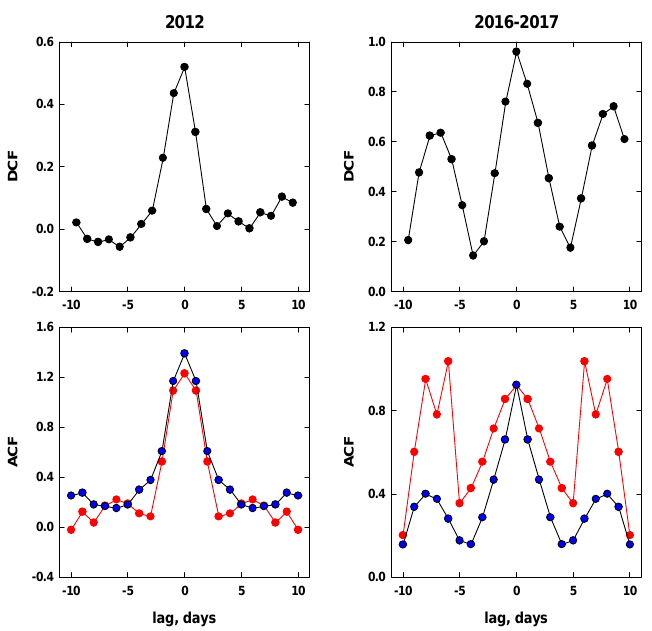
Figure 2. Upper left: Discrete Correlation Function (DCF) of optical R-band flux and γ -ray flux for CTA 102 during the outburst of 2012, adapted from [1]. Upper right: The same for the outburst of 2016–2017. Bottom panel: auto-correlation functions for corresponding time intervals: red—for optical R flux, blue—for γ -ray flux. During both outbursts, there are no delays between γ -rays and optical, implying that the sites of synchrotron and IC radiation are co-spatial. The triple DCF in 2016–2017